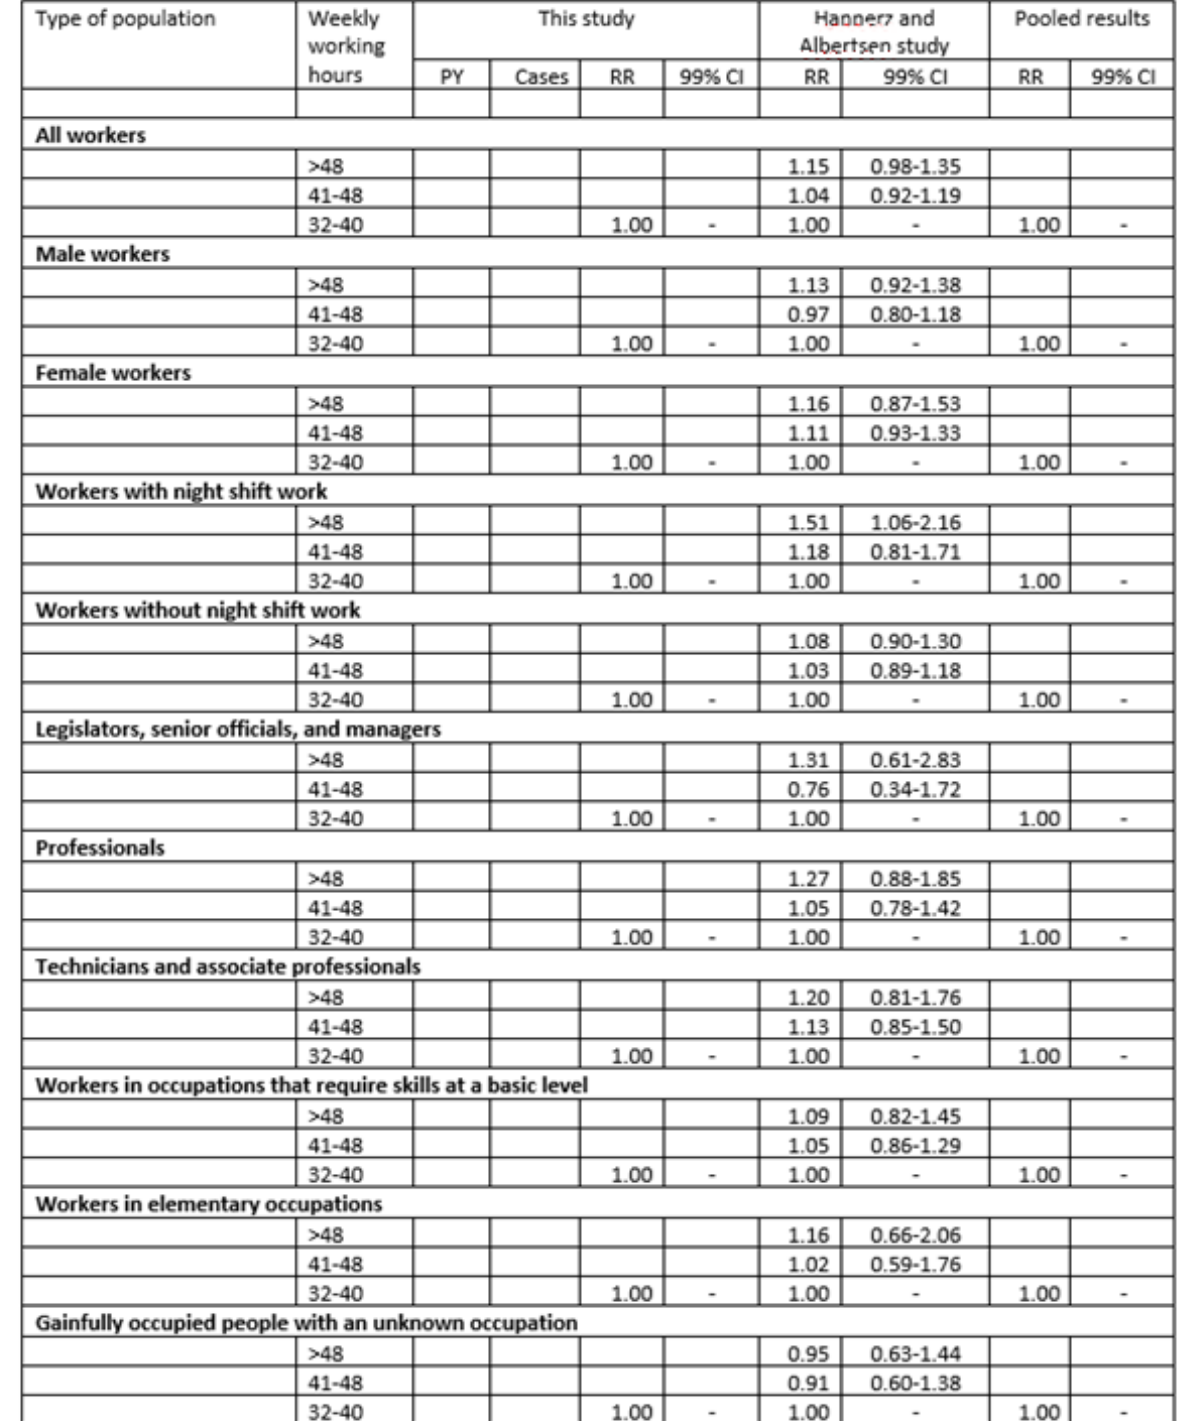
Figure 1. Dummy table: rate ratios (RRs) with 99% CIs for incident use of psychotropic drugs as a function of weekly working hours among employees in Denmark, with reference to the study by Hannerz and Albertsen [23]. PY: person years at